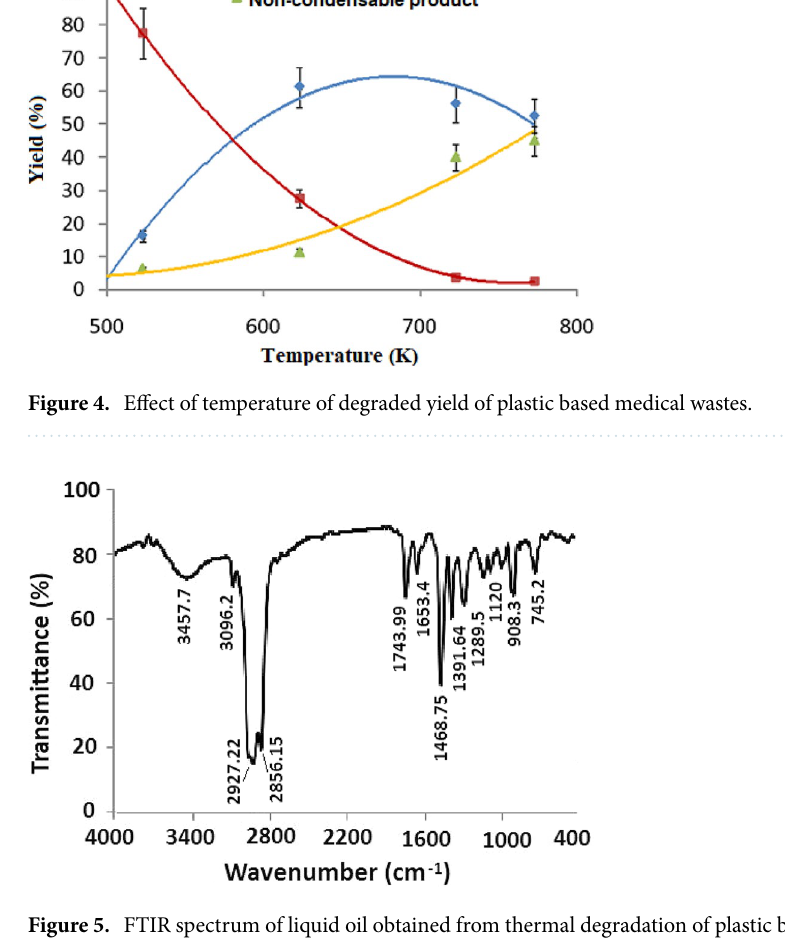
Figure 5. FTIR spectrum of liquid oil obtained from thermal degradation of plastic based medical